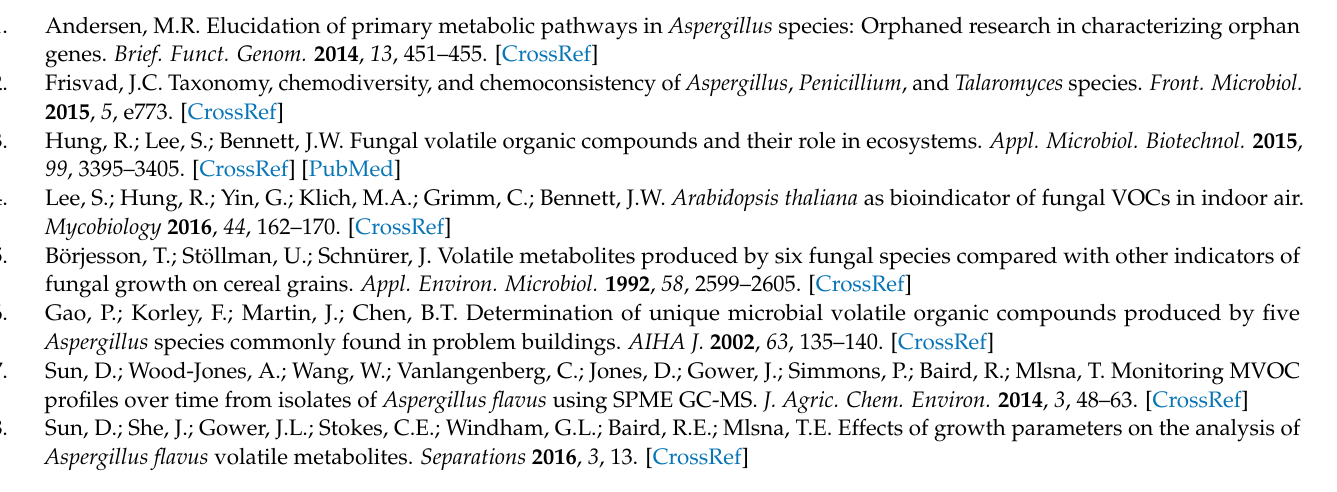
percentages (over three replicates) of VOCs contributing to total headspace profile of LA2 with each synthetic medium; Figure S5: Average percentages (over three replicates) of VOCs contributing to total headspace profile of LA3 with each synthetic medium; Figure S6: Average percentages (over three replicates) of VOCs contributing to total headspace profile of LA4 with each synthetic medium; Figure S7: Results of 2-way ANOVA involving the top three VOCs produced by examined strains on VA35 corn at the one-week time point; Figure S8: Average percentages (over three replicates) of VOCs contributing to total headspace profile of LA1 while growing on cracked kernels of VA35 (top row) and MI82 (bottom row) at each of three sampling time points; Figure S9: Average percentages (over three replicates) of VOCs contributing to total headspace profiles of toxigenic strains LA2-LA4 while growing on cracked kernels of VA35 (top row) and MI82 (bottom row) at each of three sampling time points; Figure S10: Structural formulas for the LA1-specific VOCs to be tested for potential biocontrol properties; Figure S11: Structural formulas for the VOCs present in LA2-LA4 to be investigated as potential biomarkers for the presence of crop infection by aflatoxigenic fungi. [51–66] are cited in the supplementary